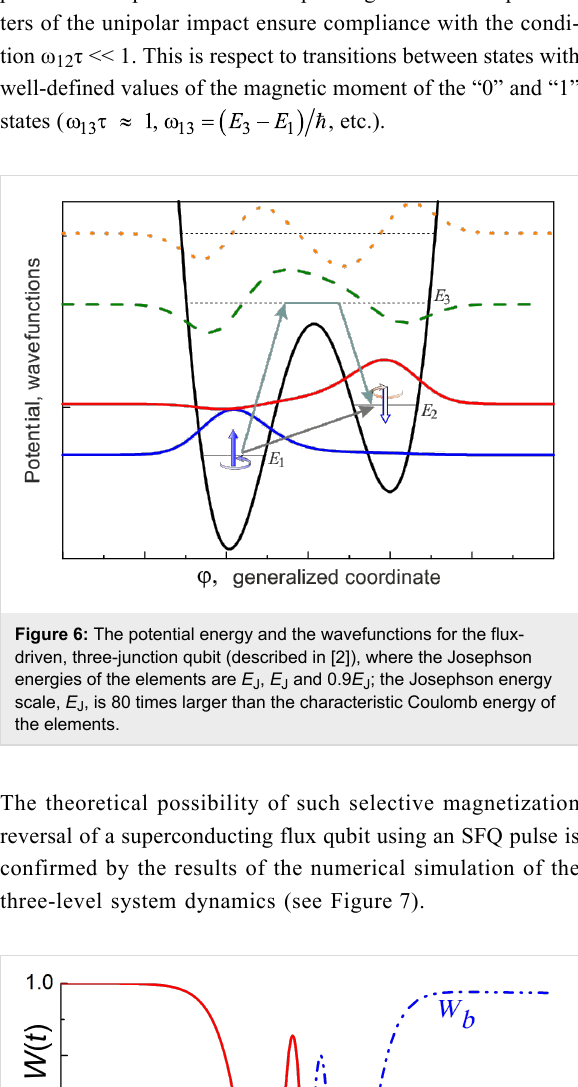
for the flux-driven, three-junction qubit are presented in Figure 6. The selective excitation of magnetization reversal is possible if the parameters of the qubit together with the parame- ters of the unipolar impact ensure compliance with the condi- tion ω 12 τ << 1. This is respect to transitions between states with well-defined values of the magnetic moment of the “0” and “1” states ( , etc.).